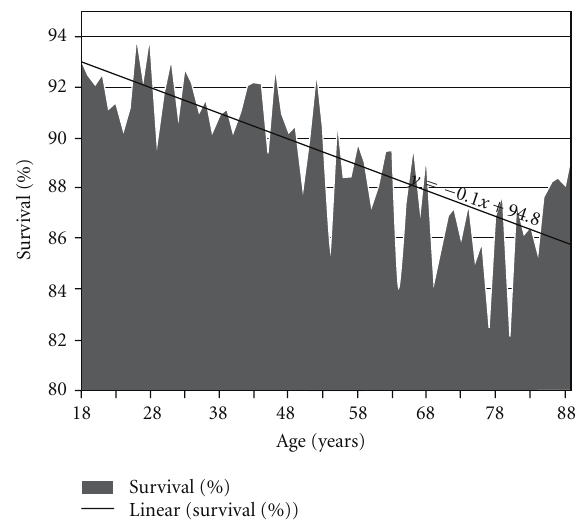
Figure 1: Percentage survival per age of patients with pelvis frac-